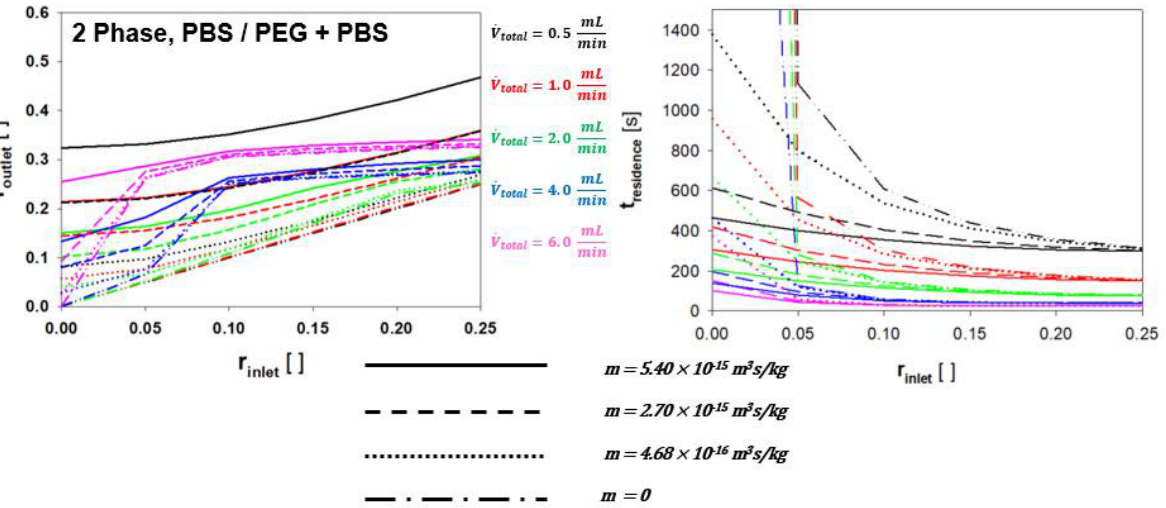
Figure 6. Predicted RBC crossover ( left ) and residence times ( right ) using the Euler method for four different mobilities (represented by differing curve patterns) and five flow rates (different colors) for a chosen entrance boundary (and therefore interface) at r(cid:3548) = 0.25.